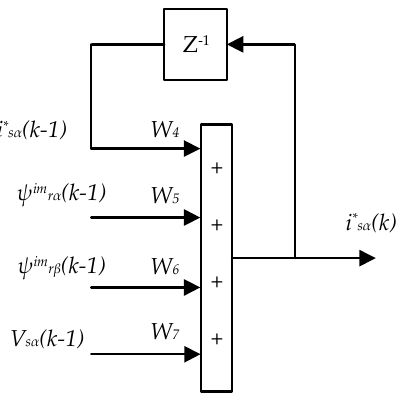
Figure 3. α - axis stator current estimation using artificial neural network.